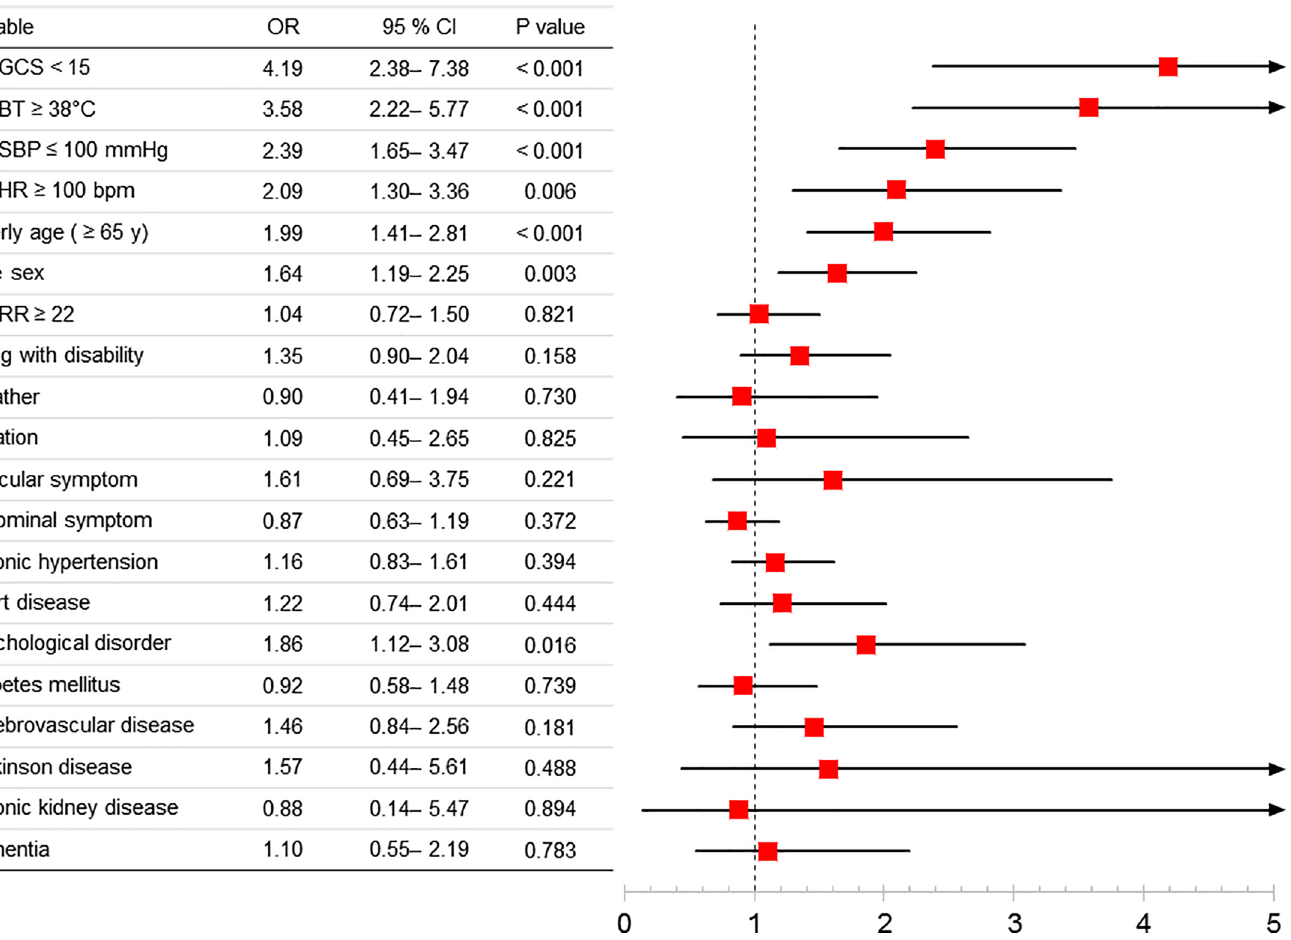
Fig 2. Logistic regression analysis for prediction of hospital admission in patients with heat-related illness.